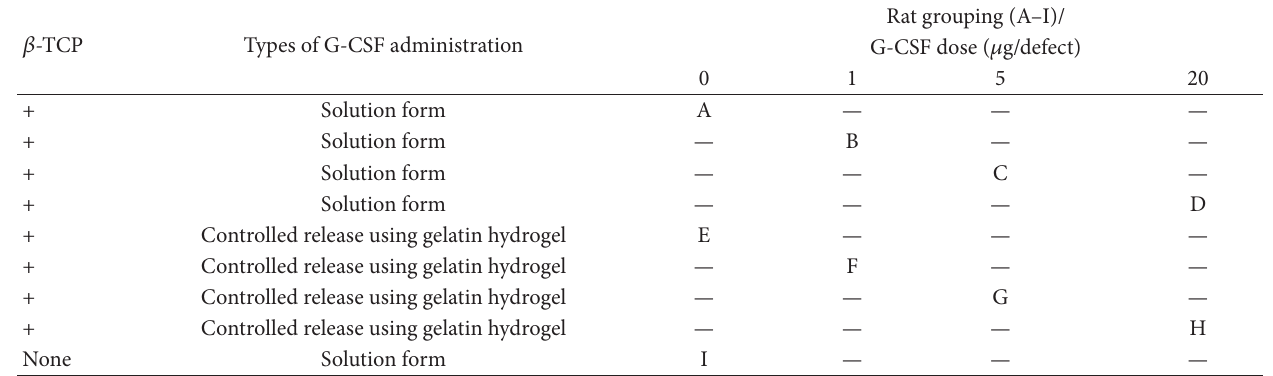
Table 1: List of the experimental